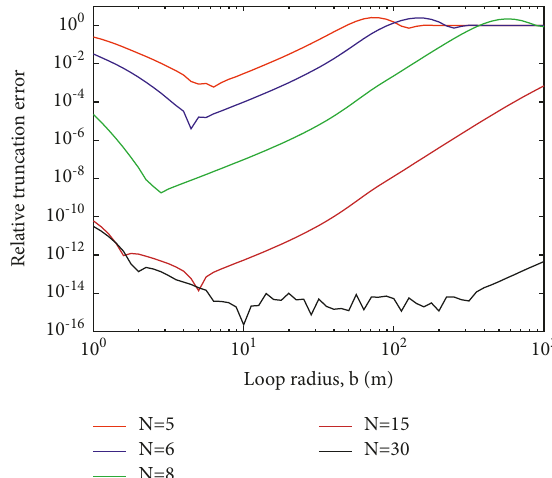
Figure 4: Relative truncation error of (34) against the radius of the source loop, with the truncation index N taken as a